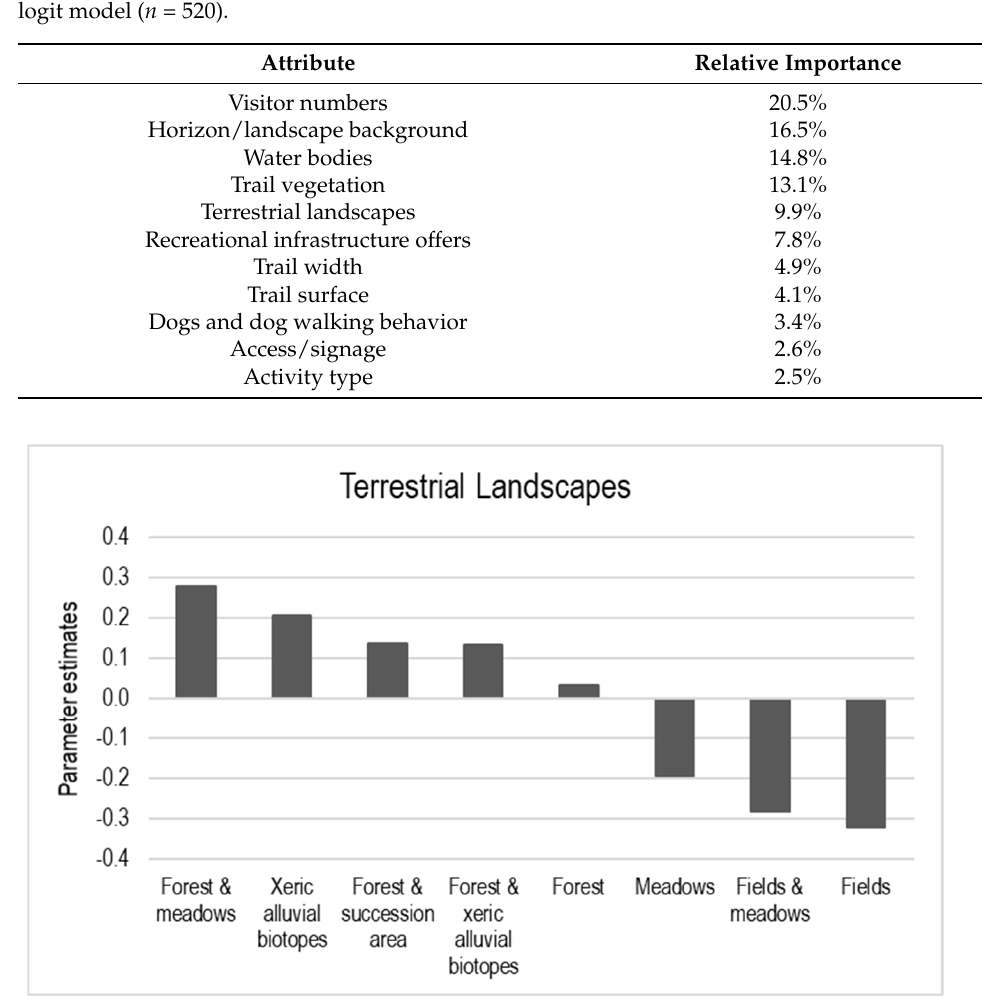
Figure 5. Preferences for terrestrial landscapes ( n = 520).